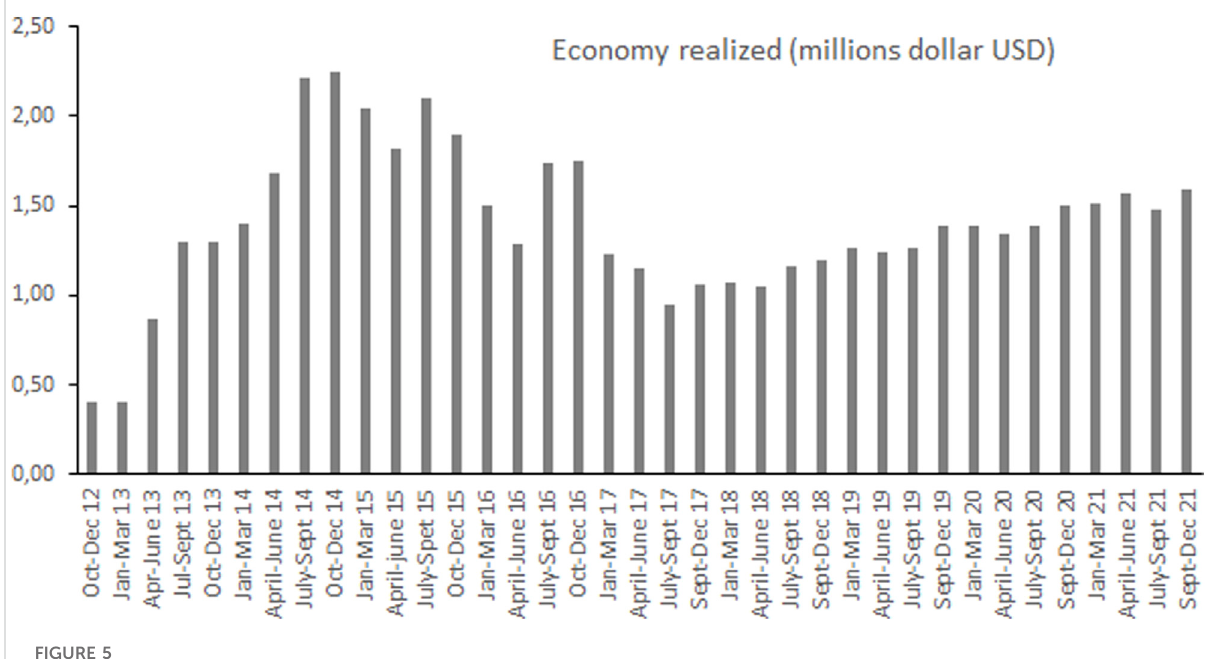
FIGURE 5 Comparison of fuel purchase expenses and economy realized.